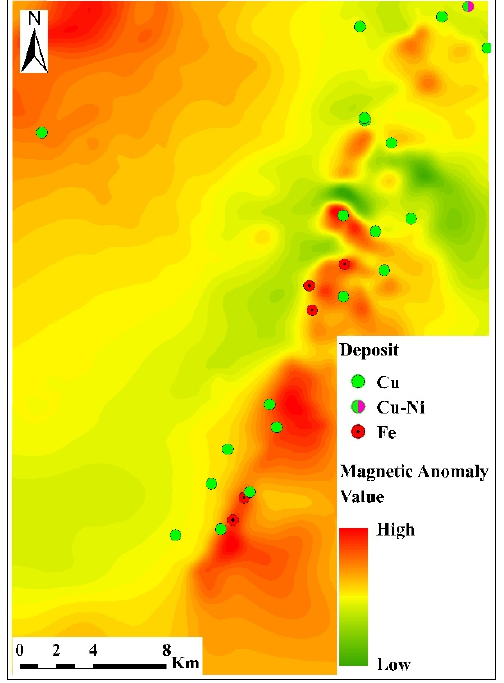
Figure 6. Aeromagnetic anomaly map.